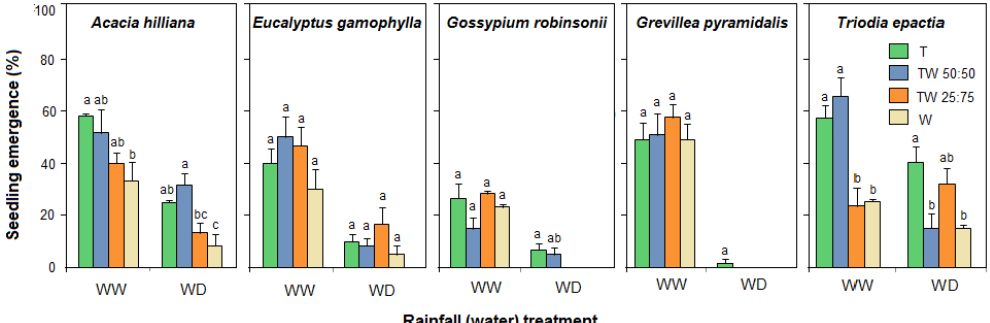
Figure 3. Total seedling emergence (%, mean ± SE, n = 12) of Pilbara native plant species for different growth media types (T: 100% topsoil, TW 50:50: mix of topsoil and waste at 50:50 ratio, TW 25:75: mix of topsoil and waste at 75:25 ratio and W: 100% waste) and watering treatments (WW: well watered and WD: water deficit). Different letters indicate significant differences over time among watering treatments for each temperature scenario (LSD post hoc test, P < 0.01).